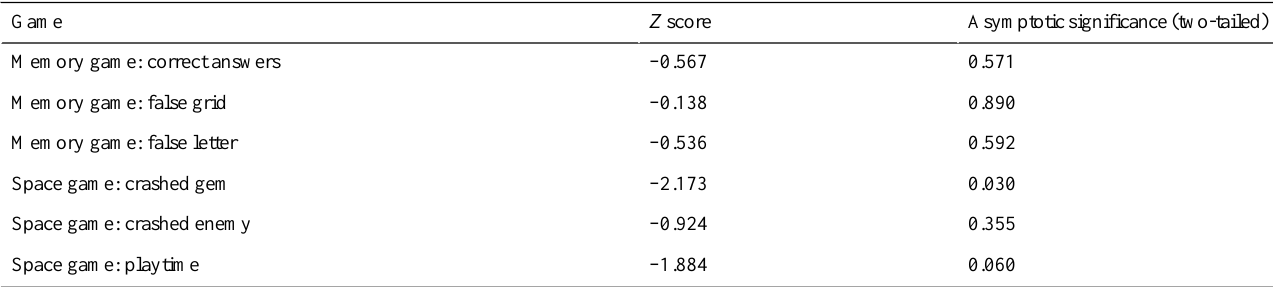
Table 2. Wilcoxon signed rank test: results of test between data of two versions of both games from the second session with students.